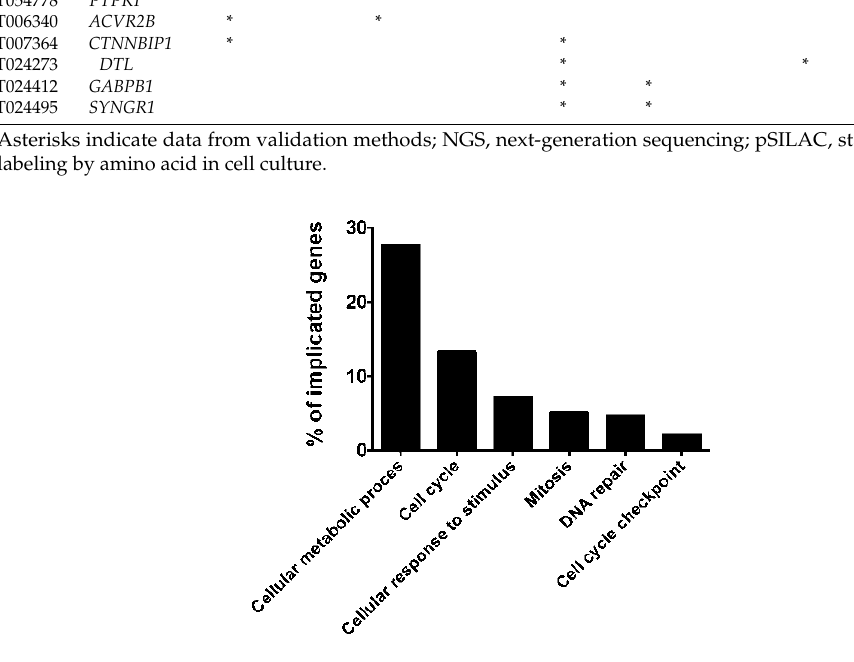
Figure 3. A functional annotation analysis using DAVID Bioinformatic tools v6.7 [24] demonstrated that the target genes for miR-215 were highly represented in the categories of cellular metabolic process (Gene Ontology (GO): 44237), cell cycle (GO: 07049), cellular response to stimulus (GO: 51716), mitosis (GO: 07067), DNA repair (GO: 06281) and cell cycle checkpoint (GO: 00075). The percentages of genes that contributed to representative categories are depicted.